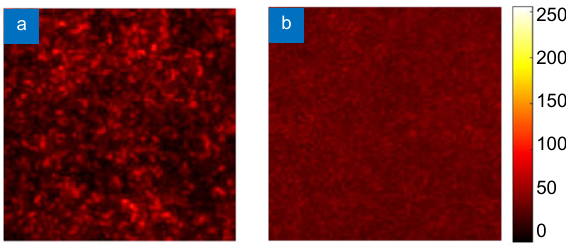
Fig. 6 | The speckle patterns before (a) and after (b) loading the 4-order PPA. The speckle contrast is reduced from 0.45 to 0.12, and a relative ratio γ = 26.67% is